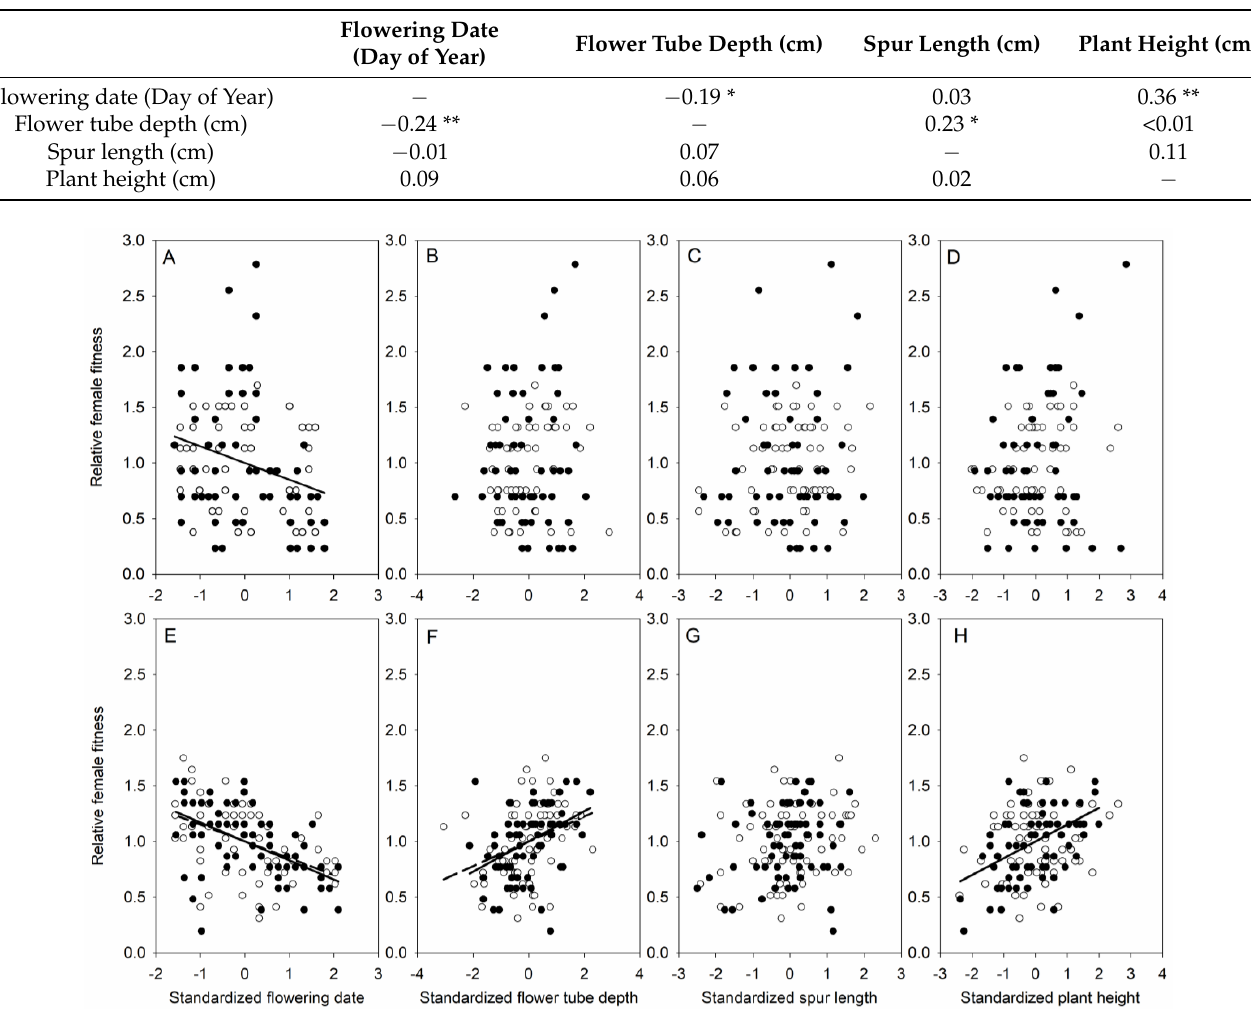
Table 2. Phenotypic correlations among the flowering date, flower tube depth, spur length, and plant height in the populations of Halenia elliptica with a low selfing rate (LSR) from Lijiang (above diagonal) and a high selfing rate (HSR) from Huangyuan (below diagonal). One and two asterisks indicate the significant relationships at the 0.05 and 0.01 levels.